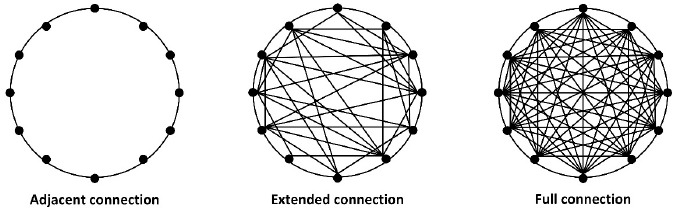
Figure 5. Typical connection between individuals in a population.